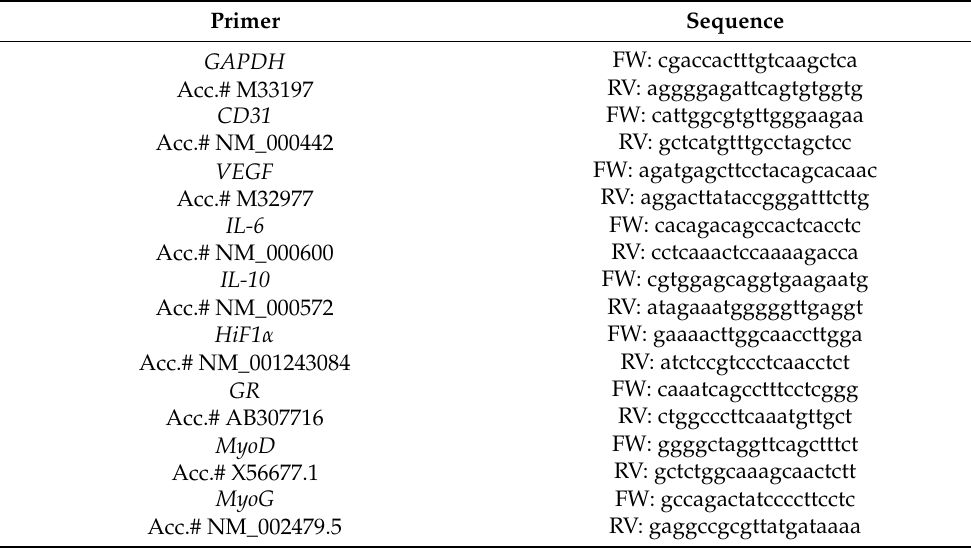
Table 3. Primer sequences for qPCR analysis (Eurofins Genomics, Ebersberg,